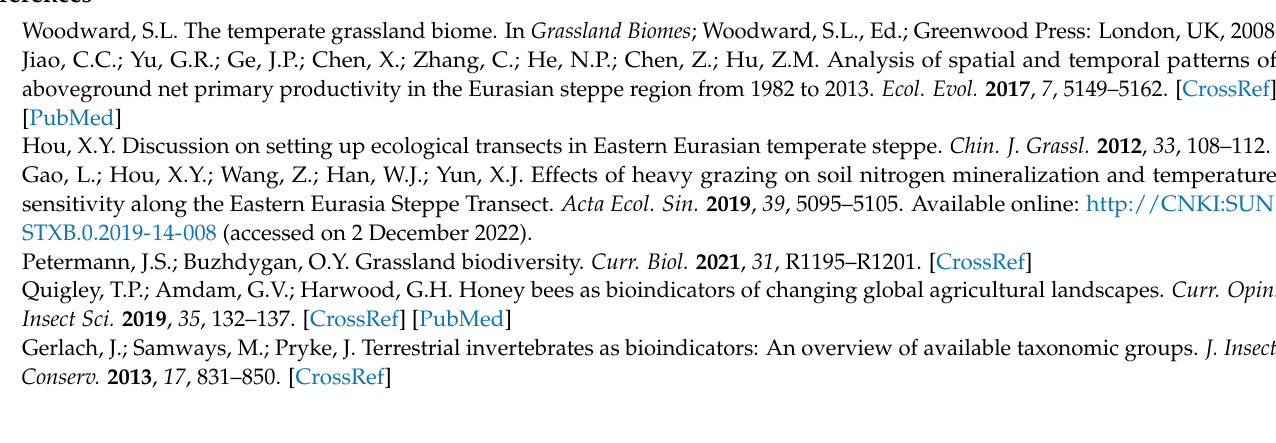
EEST; Figure S3: Distribution of the number of sites occupied by the 100 insect species collected from 10 sites in the EEST; Table S1: Sampling site information in terms of their grassland types; Sobs = observed insect species richness, SC = sample coverage. Latitude and longitude data correspond to the centroid at each site; Table S2: List of species collected in 40 samples from 10 sites across the latitude gradient in the EEST. The table is filled with species occurrences (i.e., number of one site in which a species was collected regardless of the number of individuals). Table S3: Environmental variables of 40 samples from 10 sites across the latitude gradient in the